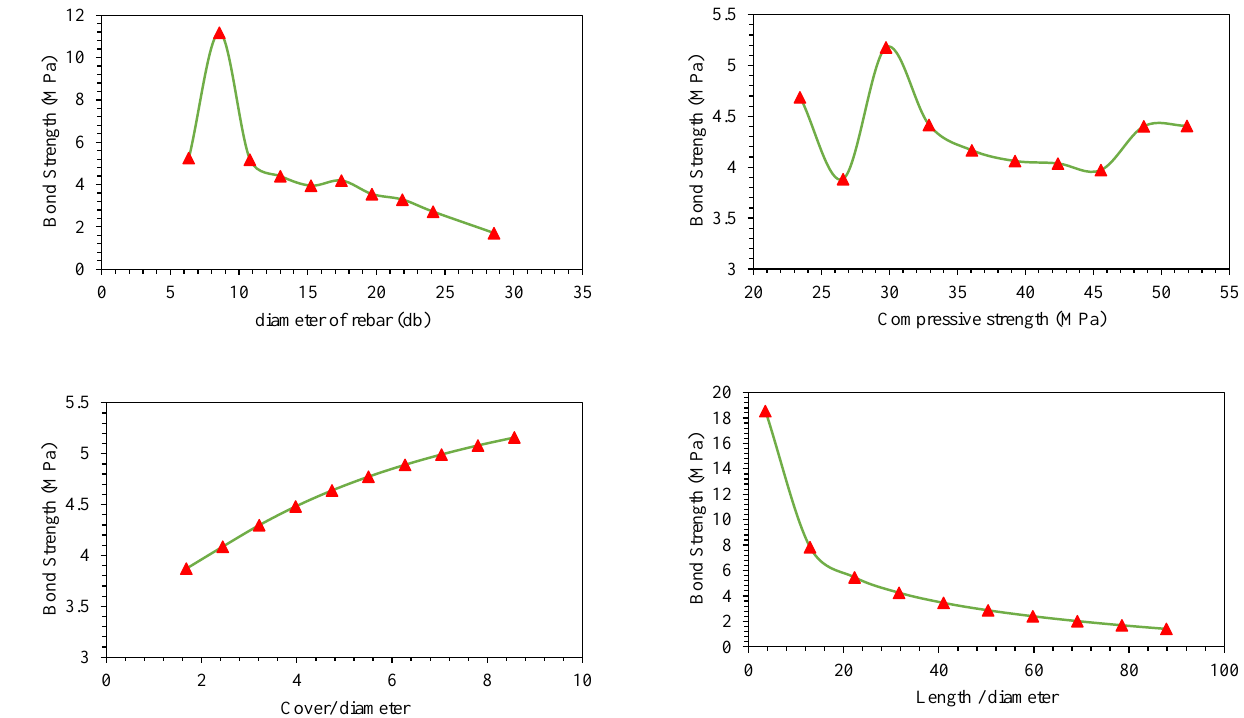
Figure 14. Effect of the contributing parameters on BS for B p type-II and B s type I.